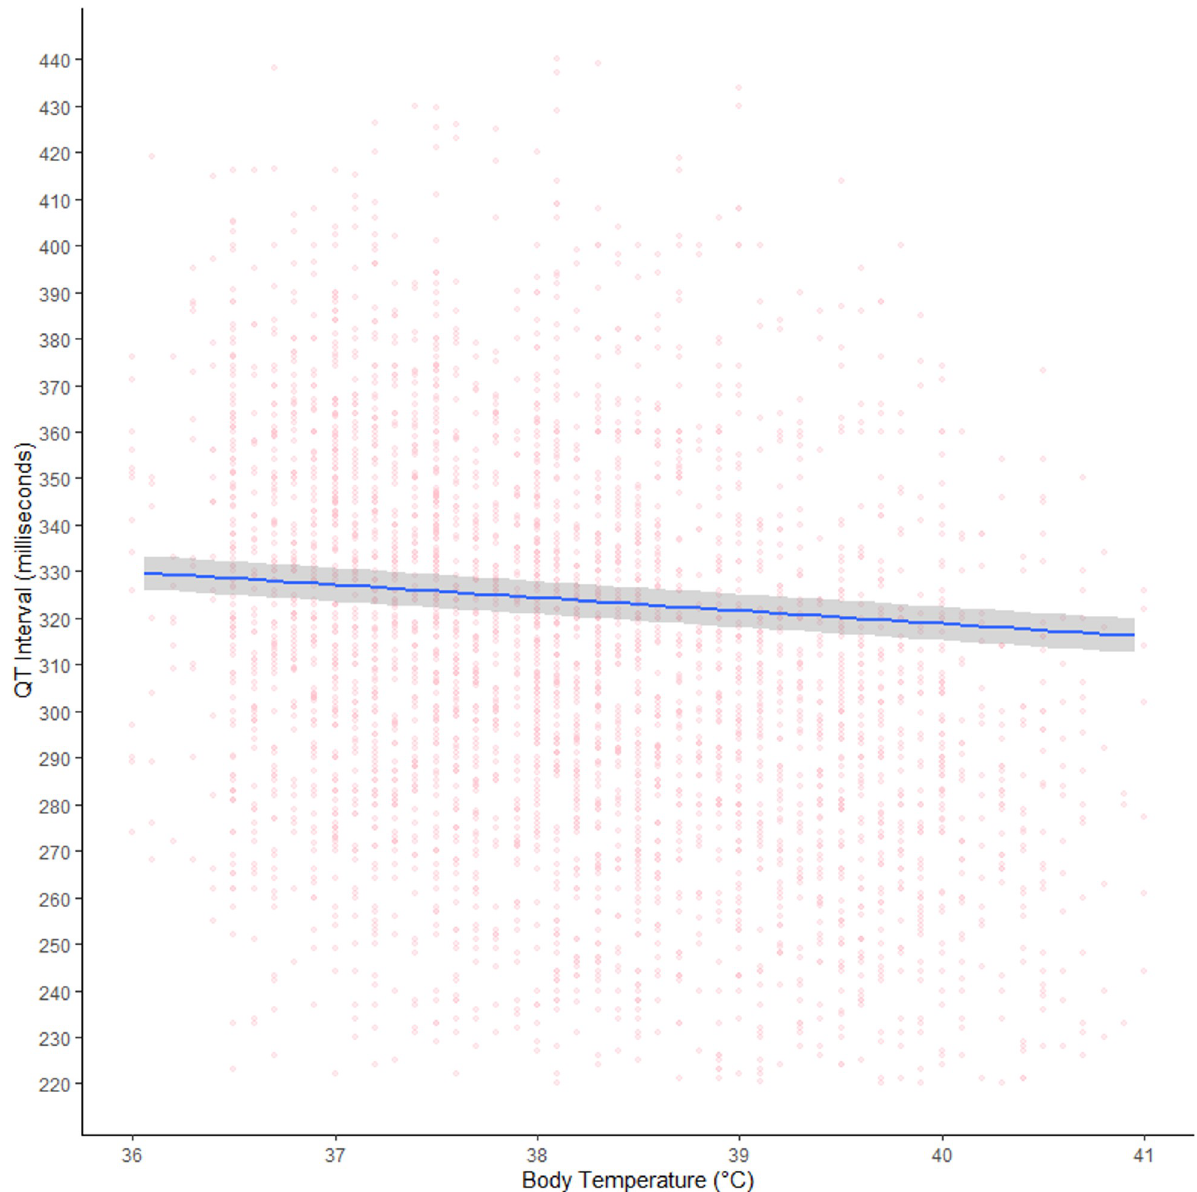
Fig 2. Body temperature and the QT interval in malaria. Independent effect of body temperature on the QT interval from hierarchical generalised additive model adjusting for heart rate/RR interval (as represent original data points without adjustment. CI, credible